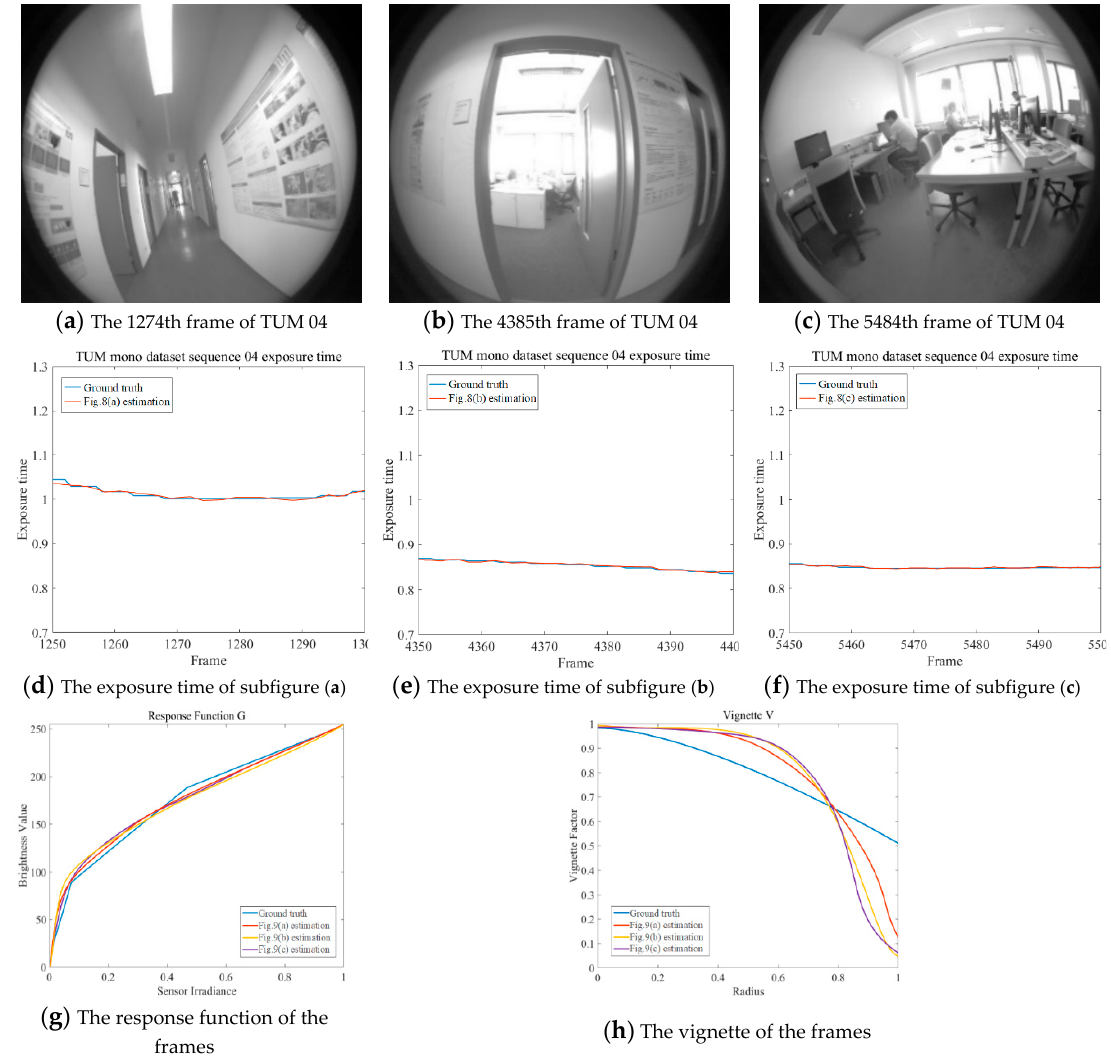
Figure 9. The photometric parameters of randomly selected frames. It can be seen that the estimated exposure times were very close to the ground truth. However, the parameters of response function and vignette were acutely adjusted to fit the pixels’ intensity of the different scenes.